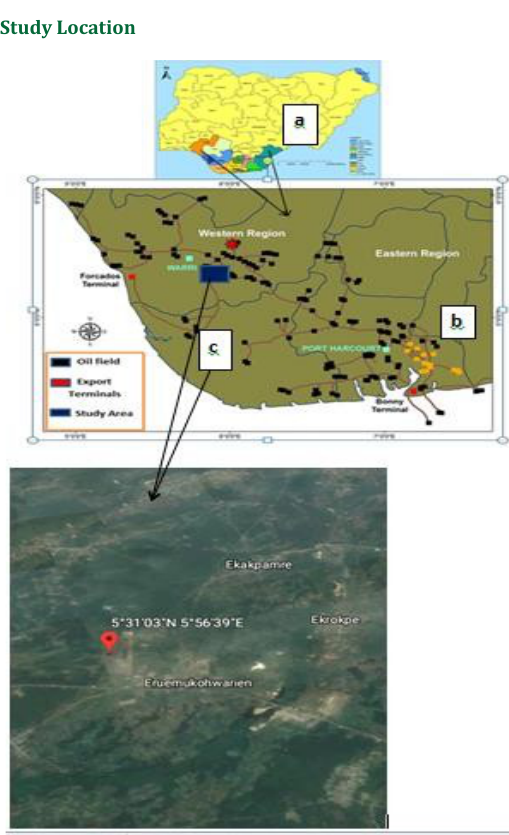
Figure 1: a. Map of Nigeria showing the Niger Delta Region b. Map of various oil fields (represented in black boxes), after Adeoti et al., 2015; the purple lines show interconnection of oil and gas pipelines, the red boxes